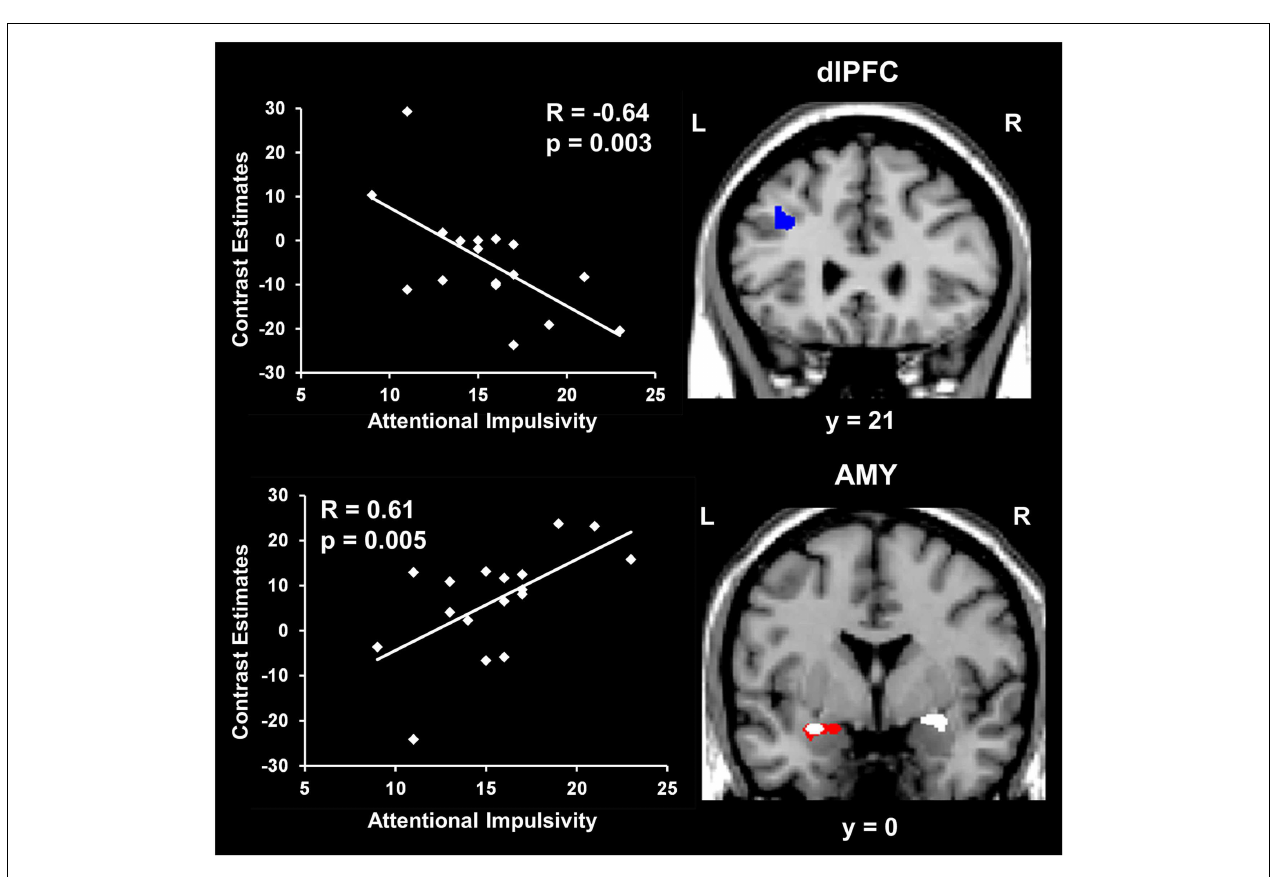
for emotional vs. neutral distracters and AI scores. Contrast estimates in the scatter plots are extracted from the peak voxels in right AMY (Talairach coordinates: x = 25, y =− 1, z =− 6) and left dlPFC (Talairach coordinates: x =− 35, y = 21, z = 38).The activation maps are superimposed on a high-resolution brain image displayed in coronal view ( y indicates theTalairach coordinates on the anterior-posterior axis of the brain). AMY, amygdala; dlPFC, dorsolateral prefrontal cortex. Error bars represent standard errors of